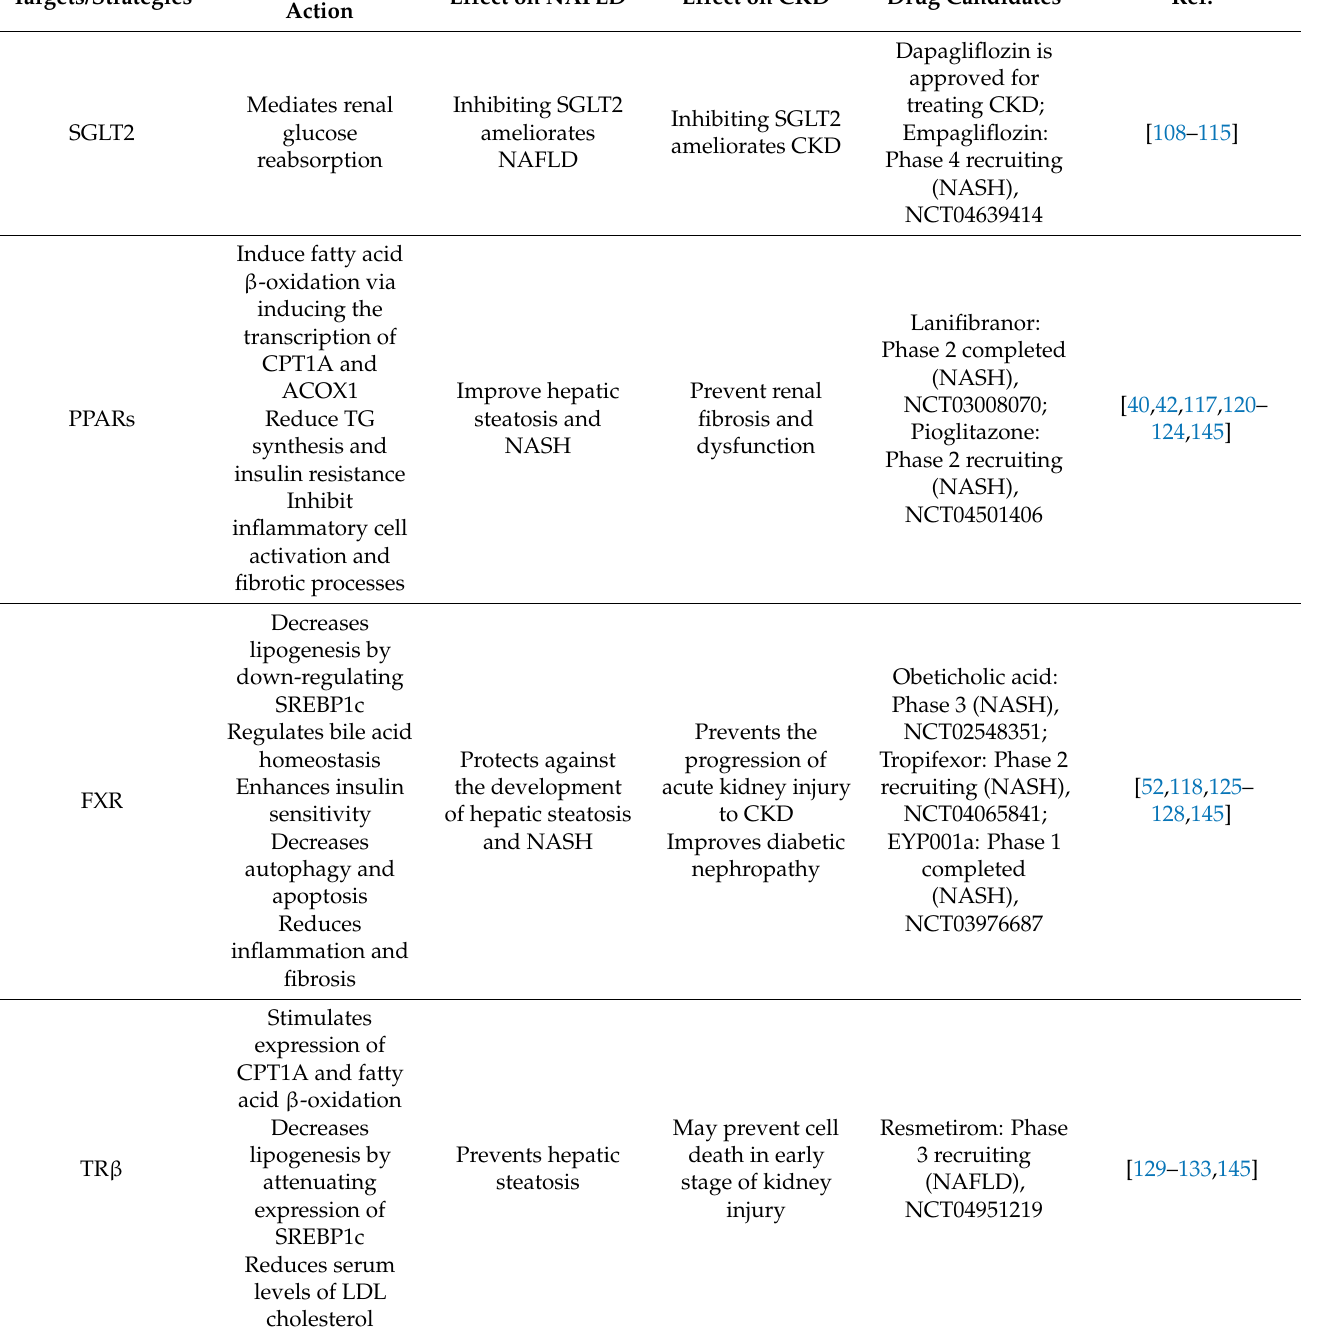
Table 1. Roles of potential therapeutic targets/strategies in the pathogenesis of NAFLD and CKD. Mechanism of Effect on NAFLD Effect on CKD Drug Candidates Targets/Strategies Action